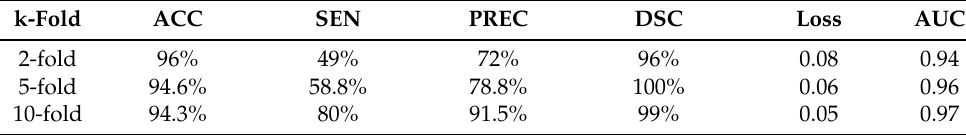
Table 9. The average validation values of ACC, SEN, PREC, DSC, and AUC by using k-fold CV.